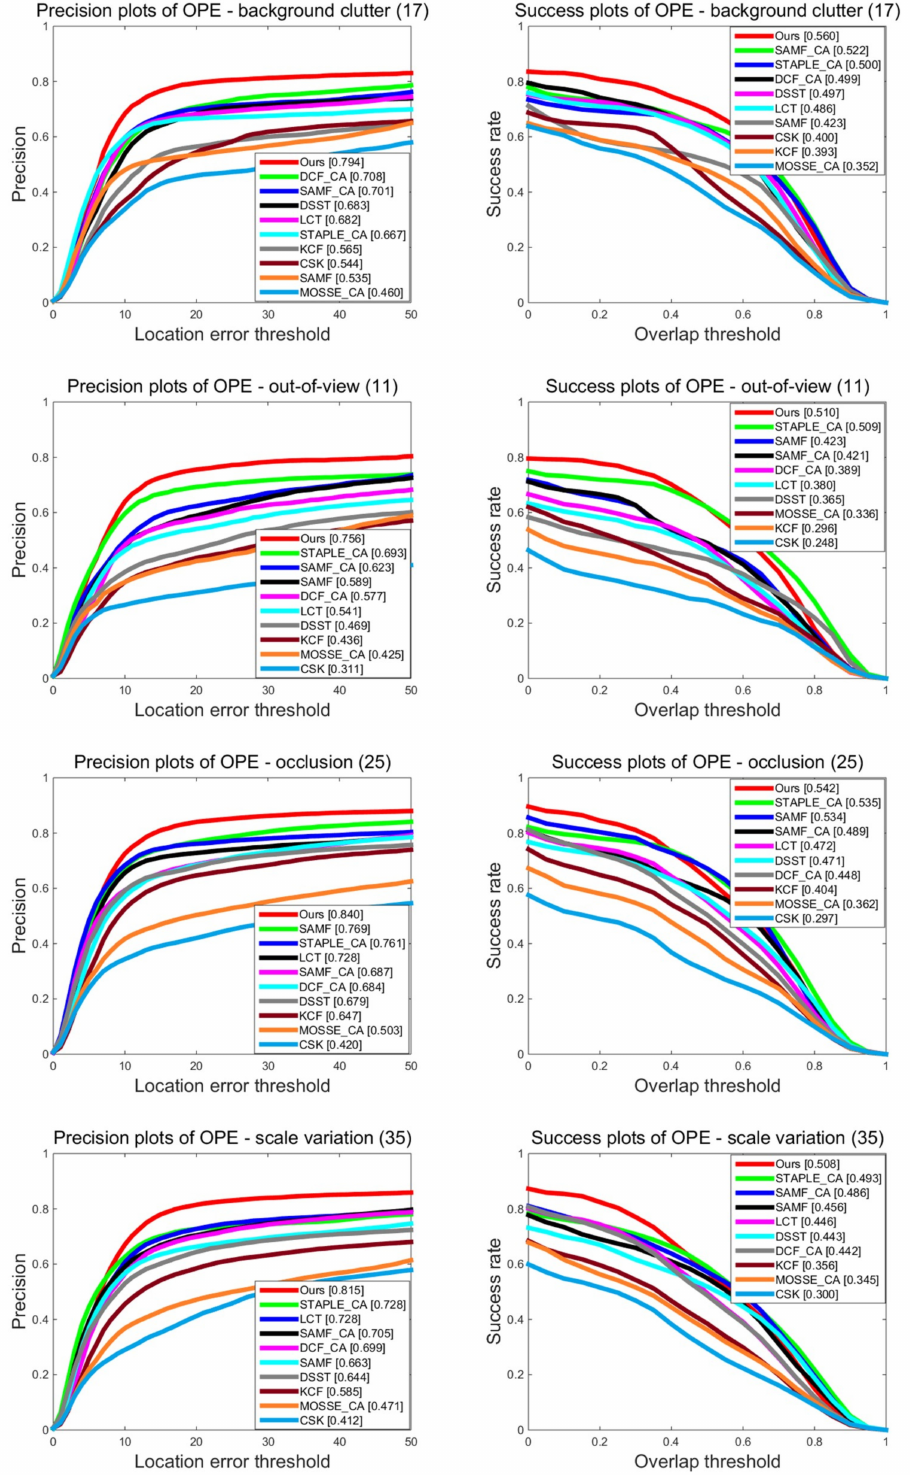
Figure 5. Attribute based evaluation of Success plots compare the proposed algorithm with 10 CF based trackers over seven challenges of illumination variation, in-plane rotation, out-of-plane rotation, background clutter, out-of-view, occlusion and scale variation. The number of sequences for each attribute is shown in